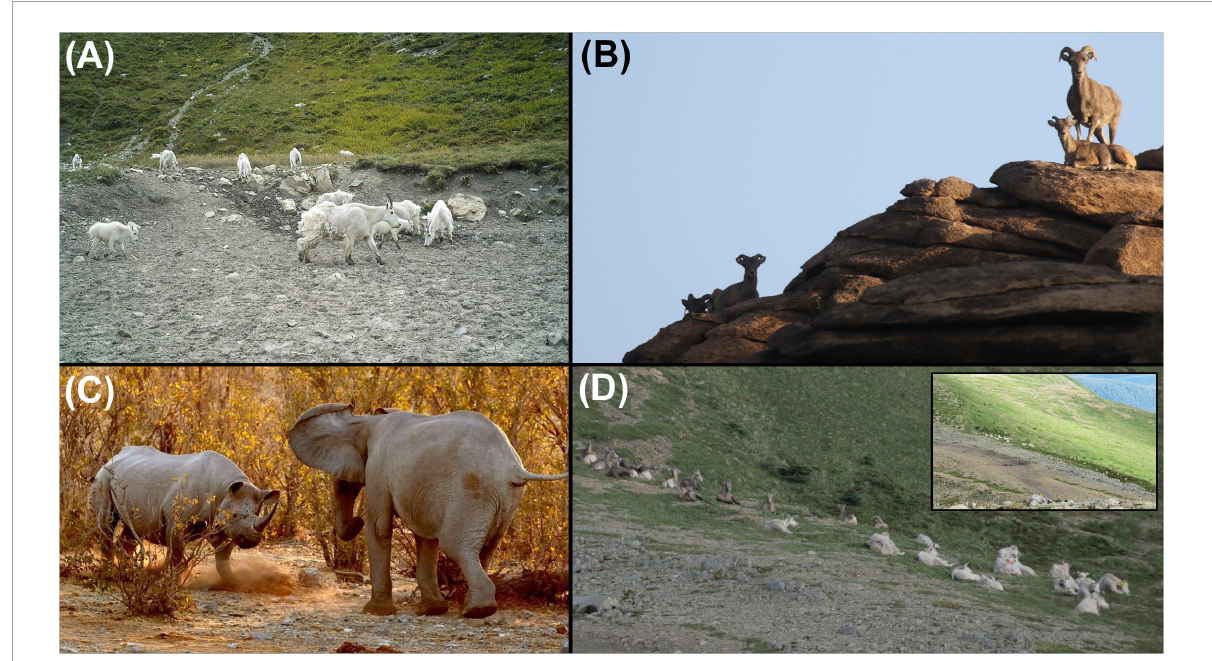
FIGURE2 Examples of conflict and tolerance. (A) Mountain goats at a mineral lick in Glacier National Park, MT (W. Sarmento). (B) Closely related taxa of mountain goats and bighorn sheep, herein – female and young Siberian ibex (left) and argali on same rocky outcrops in the Gobi Desert of Mongolia (R. Reading). (C) Black rhino and elephant in Etosha National Park, Namibia (A. Forsyth). (D) Sizeable groups of mountain goats and bighorn sheep at rest sympatrically (and inset of them in broader landscape) on Caw Ridge, Alberta, Canada (F. Dulude-de Broin).